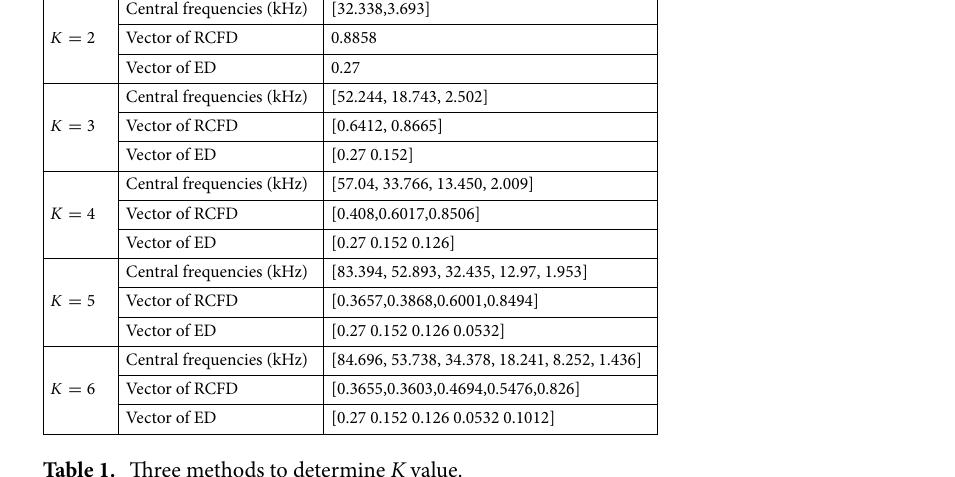
Table 1. Three methods to determine K